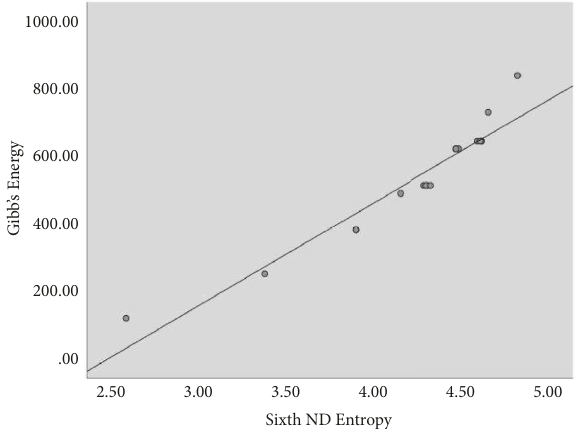
Figure 8: Graphical representation of LRM between Gibb’s energy ( GE ) and the sixth ND entropy.